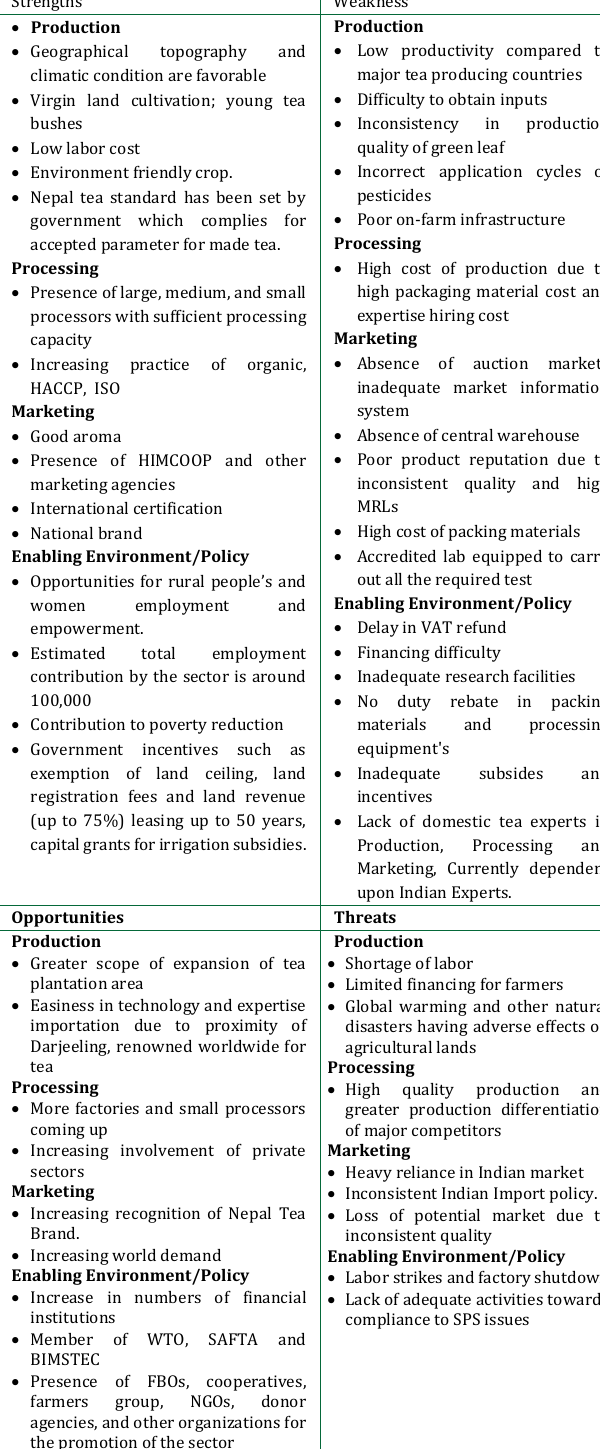
Table 2: SWOT analysis of orthodox tea sector at different stages (2018)